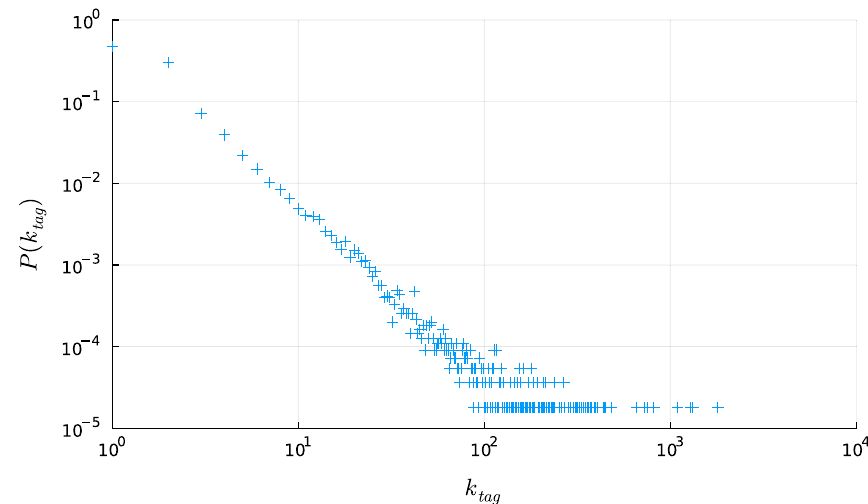
Fig. 7 Degree distribution of the hashtags in the Honduras bipartite user-hashtag network